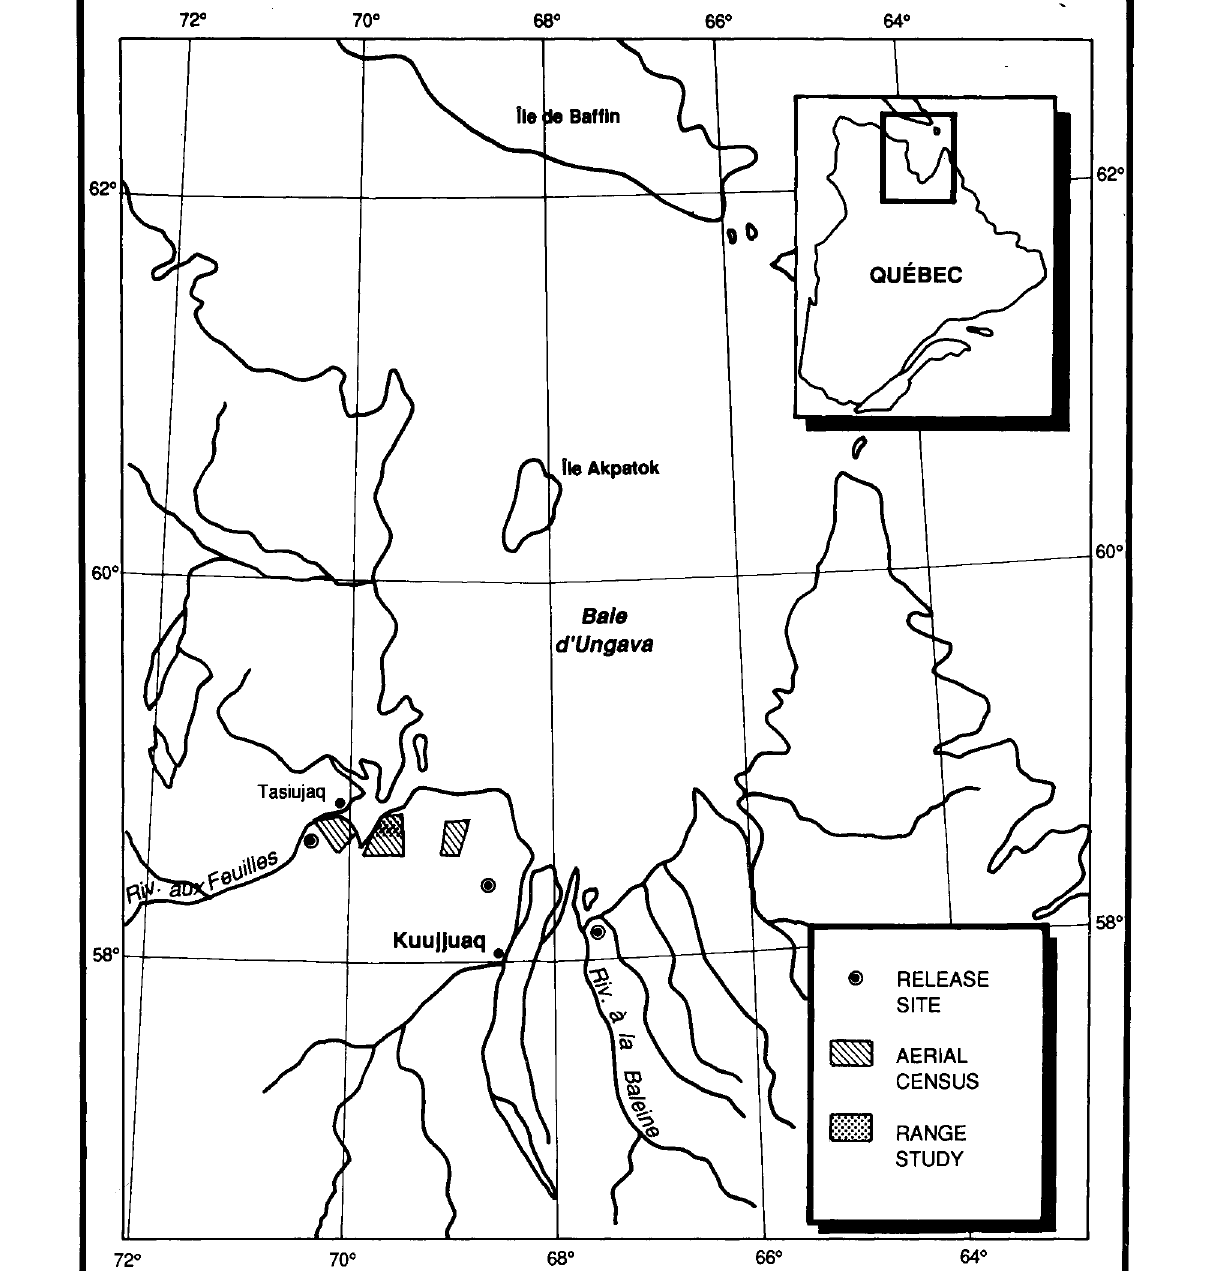
Fig. 1. Location of the area where an aerial census of muskoxen was carried out in October 1986 in northern Quebec, and area where range studies were